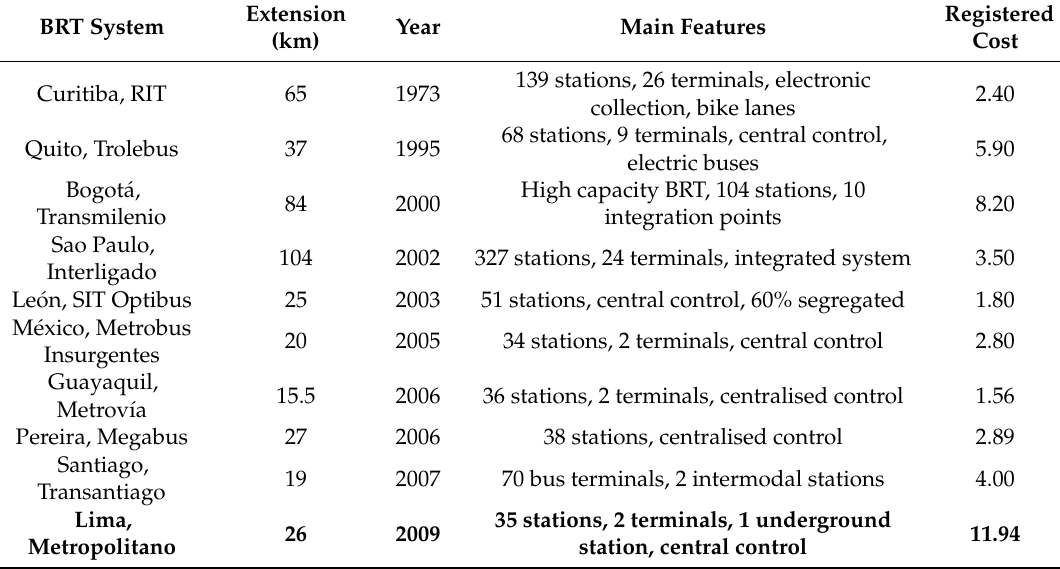
Table 2. Infrastructure cost per kilometer of di ff erent Bus Rapid Transit systems in Latin America. (in million